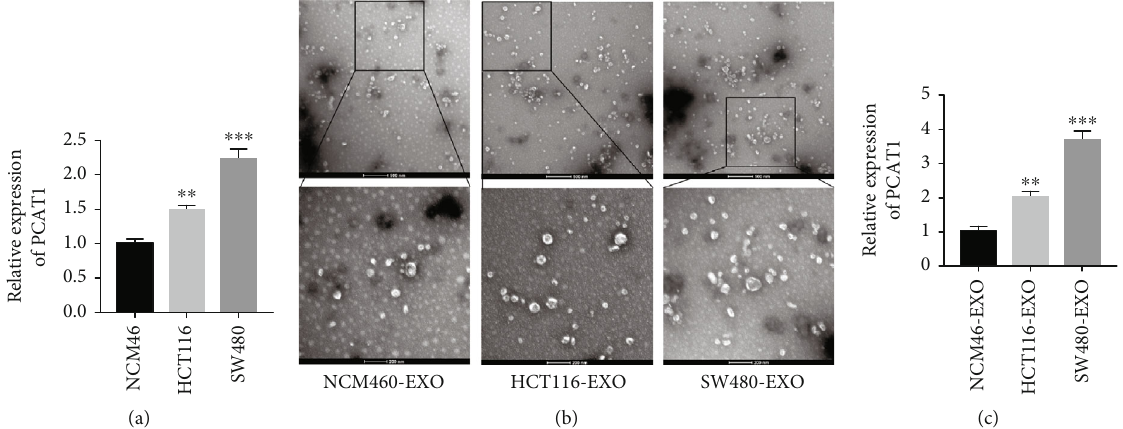
Figure 1: Expression of PCAT1 in colorectal cancer cells and their exosomes. (a) RT-qPCR was used to detect the expression of PCAT1 in HCT116 and SW480 cells. ∗∗ P < 0 : 01 , ∗∗∗ P < 0 : 001 vs NCM46. (b) The shape and size of exosomes were observed by transmission electron microscopy. (c) RT-qPCR detected the expression of PCAT1 in the exosomes. ∗∗ P < 0 : 01 , ∗∗∗ P < 0 : 001 vs